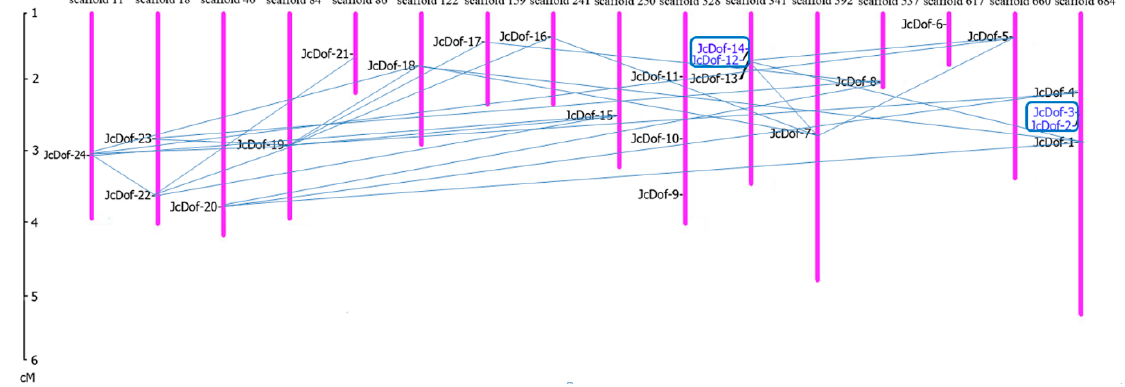
Figure 4. Chromosomal locations and gene duplication events of JcDof . Respective scaffold numbers are indicated at the top of each bar. The scale on the left is in centimorgan (cM). The JcDof gene pairs of segmental and tandem duplication are linked by pale blue lines and marked in dark blue rectangles, respectively. The detailed information of duplication pairs are described in Supplementary Table S5 .